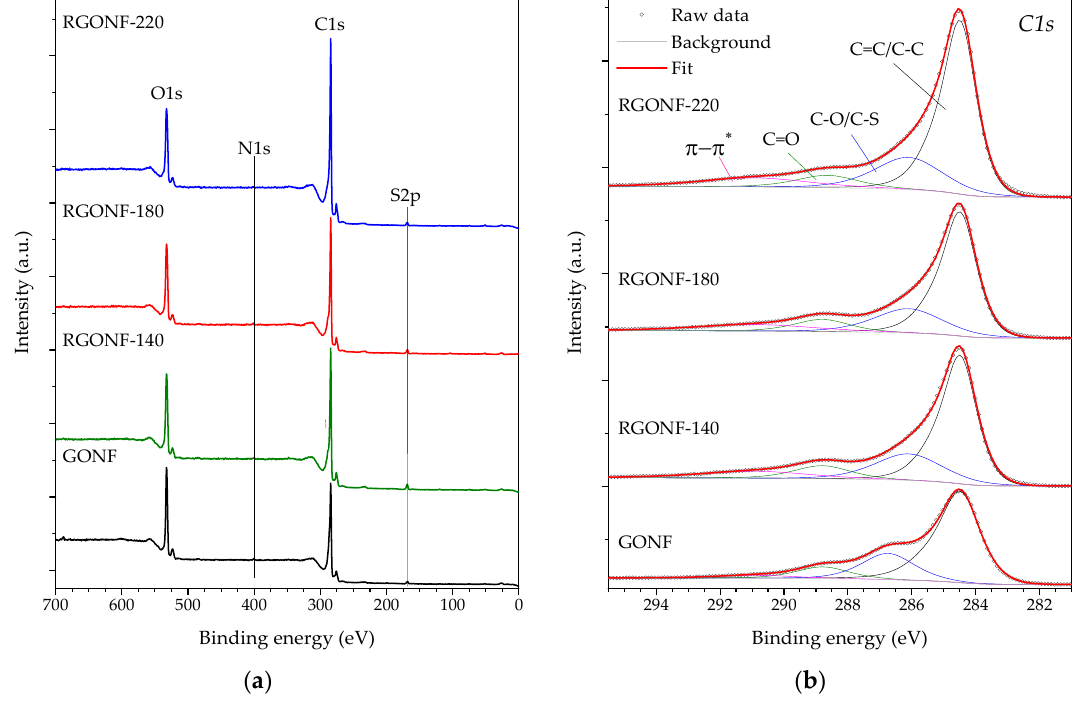
Figure 3. ( a ) X-ray photoelectron spectroscopy (XPS) Survey; and spectra of the ( b ) C1s region of GONF and RGONFs obtained at 140, 180, and 220 °C. Table 2. Bulk and surface composition measured by elemental analysis and XPS, respectively.